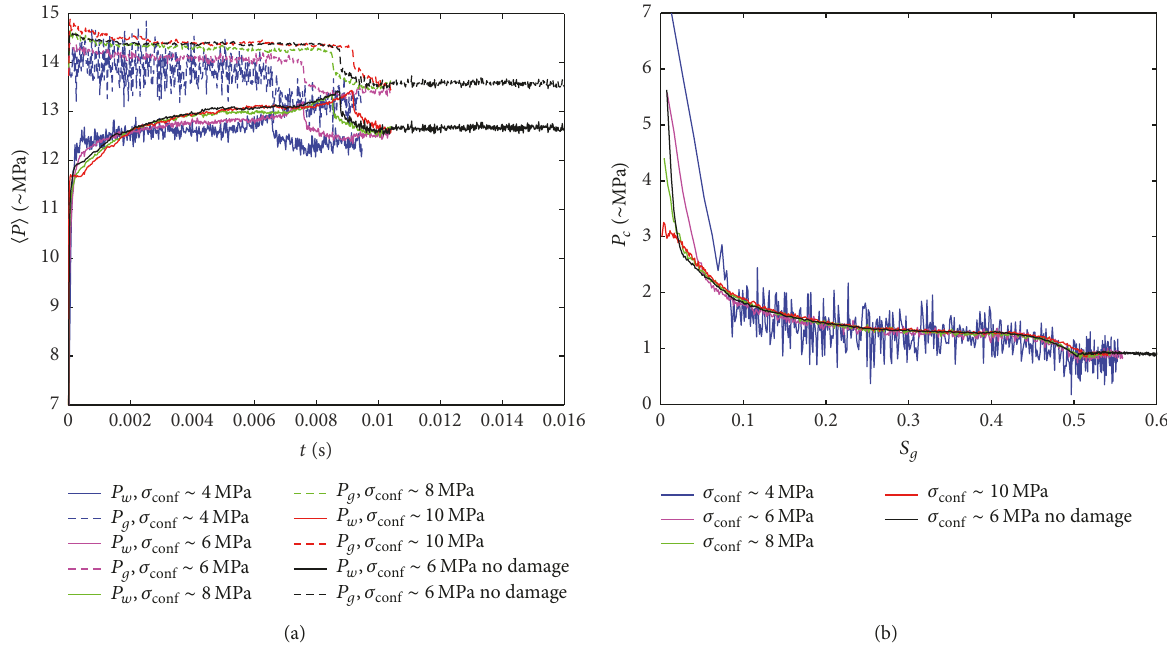
Figure 13: (a) Water and gas mean pressures inside the sample as functions of time. (b) Capillary pressure as a function of gas saturation.